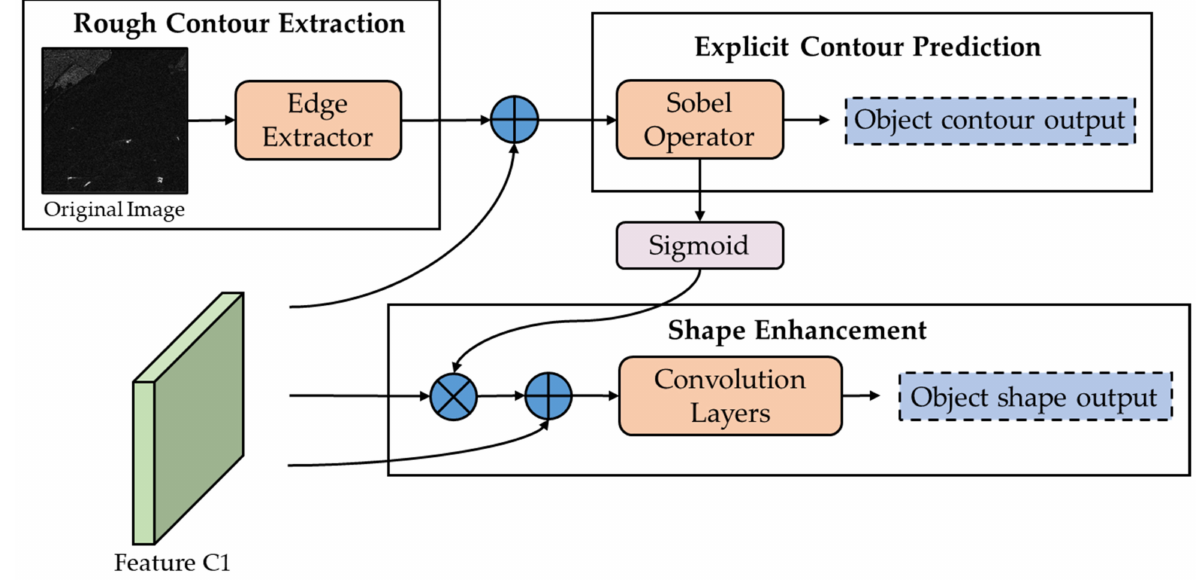
Figure 6. The structure of the contour-shape-enhancement